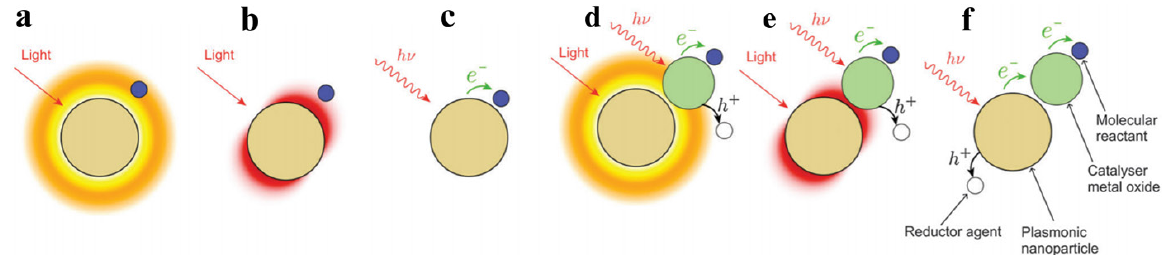
Figure 17 - Main mechanisms involved in plasmonic catalysis: a) photo-induced temperature increase provides heat to an adjacent reactant; b) the enhancement of the optical near field at the vicinity of the NP increases the photon rate seen by an adjacent reactant; c) a photoinduced hot electron is transferred to a nearby reactant; d) the electron–hole (e − –h + ) generation rate in a photocatalyst is enhanced by heat generated by the NP; e) the electron–hole generation rate in a photocatalyst is enhanced by the strong optical near-field of the plasmonic NP; and f) the photocatalyst adjacent to the NP is activated by hot electron transfer from the plasmonic NP. Adapted with permission from ref. (Baffou and Quidant 2014) Copyright 2014 Royal Society of Chemistry.